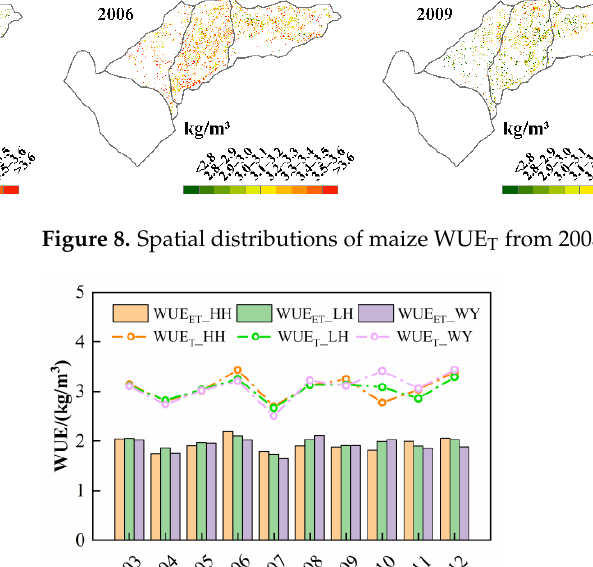
Figure 7. Spatial distributions of maize WUE ET from 2003 to 2012.